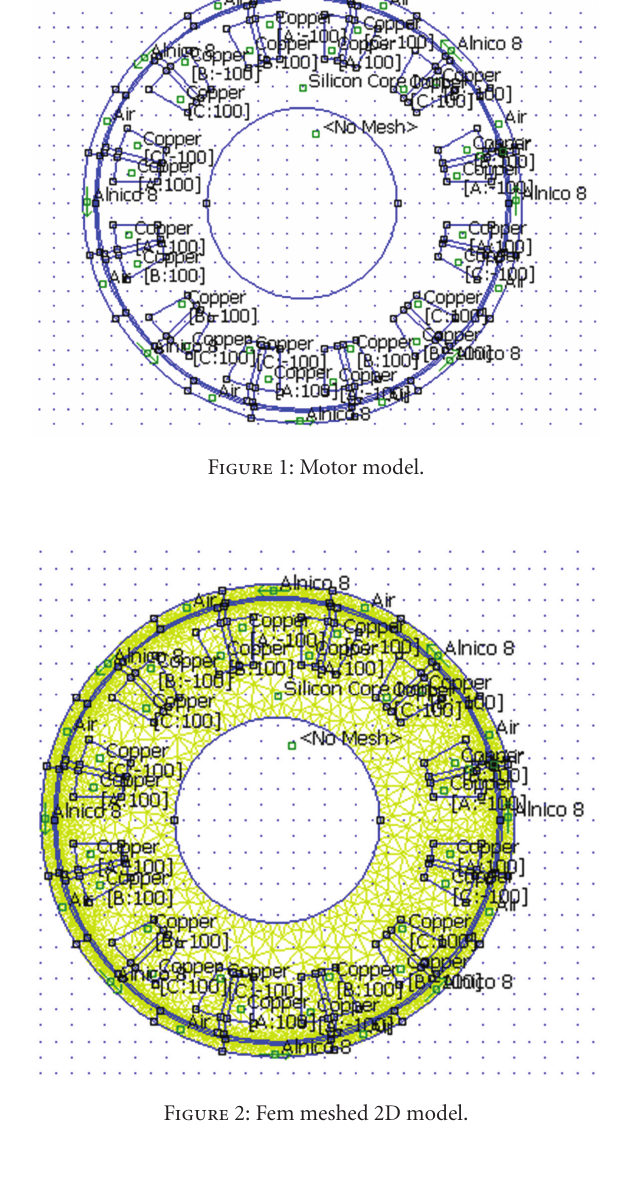
Table 1: Motor specifications.